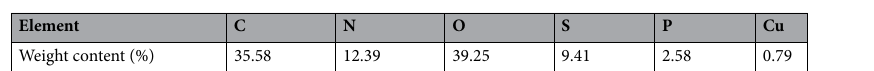
Element Weight content Table 5. EDX results of the residue char of 20DOPO-CuPc/EP after cone calorimetry test.